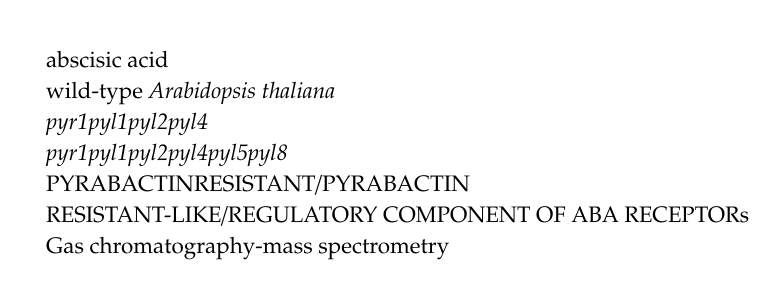
Table S1: A significant di ff erence between 1124 and WT, and 112458 and WT was